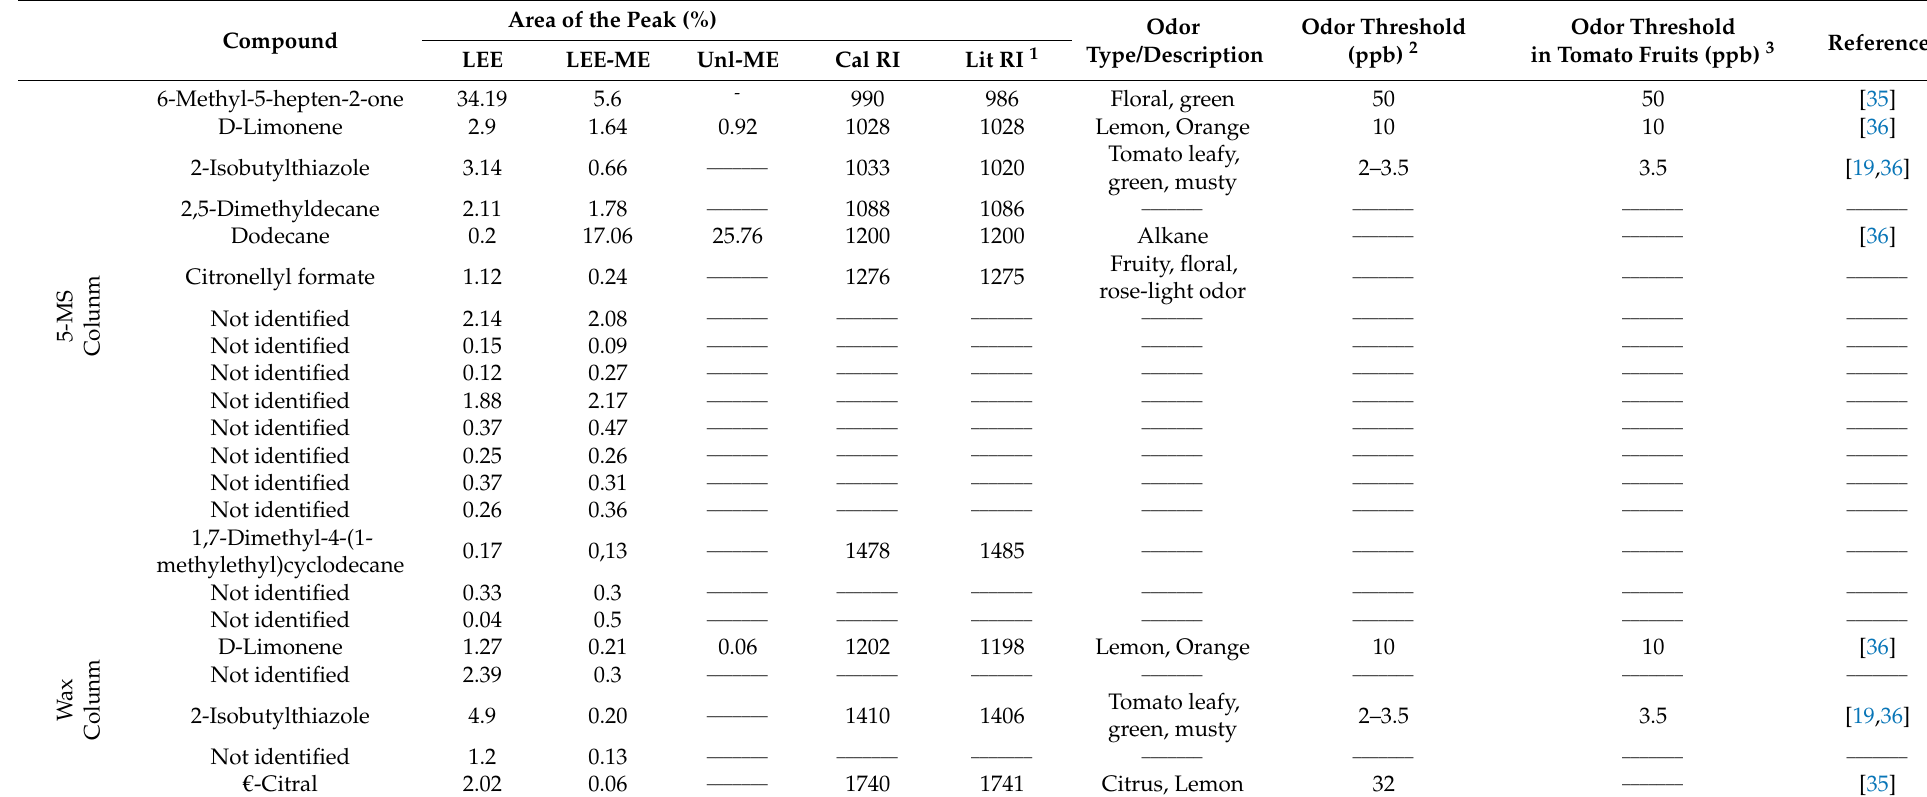
Table 1. Characterization parameters of volatile compounds in LEE, LEE-ME and Unl-ME identified through GC-MS analysis.